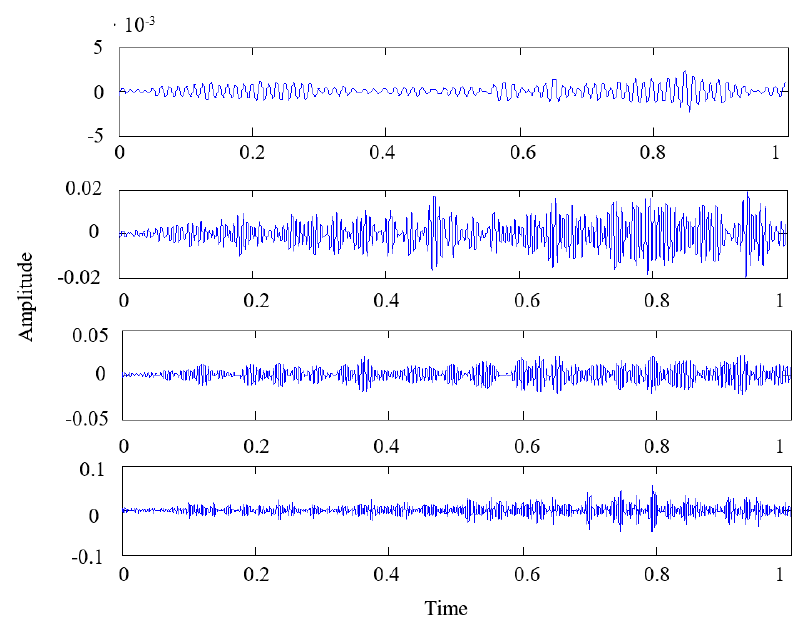
Figure 11. Angle domain waveform of extracted modes for the acoustic signal by demodulation-based empirical wavelet transform (DEWT).